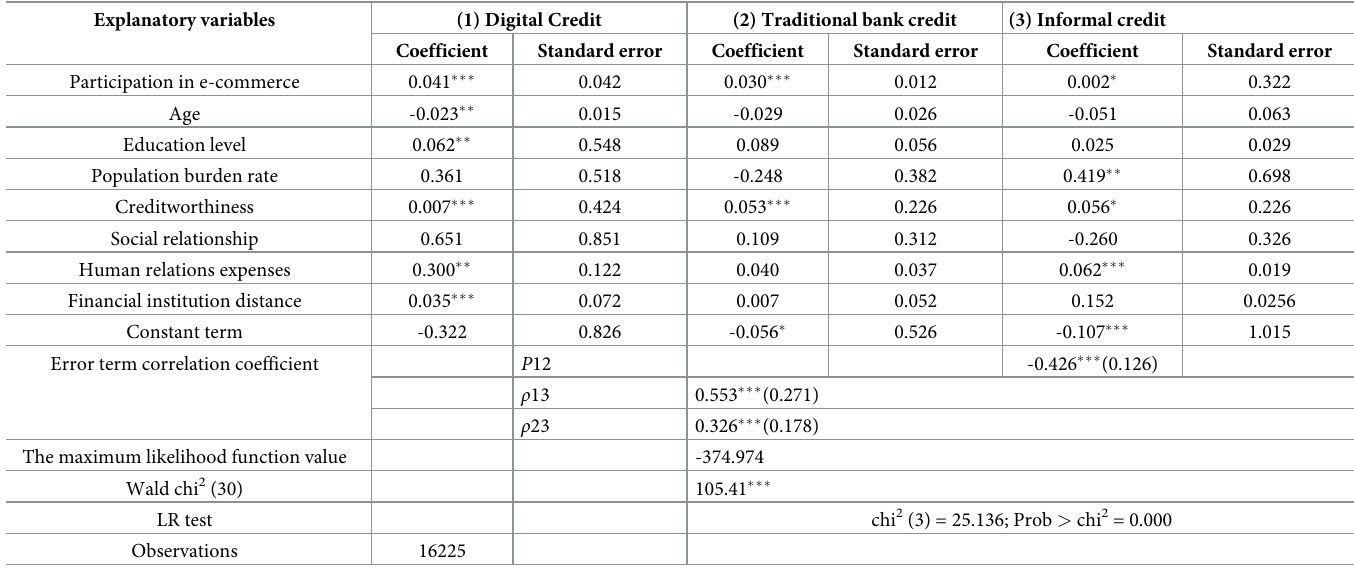
Table 3. Estimation results of the interrelationship between digital credit and traditional bank credit. Explanatory